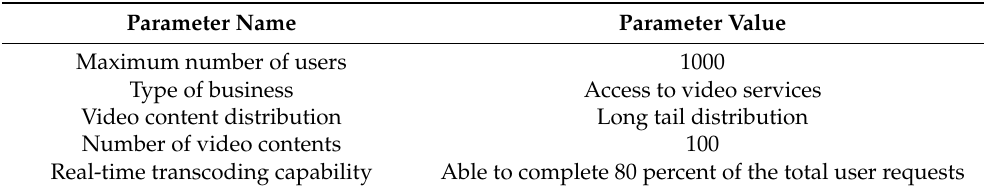
Table 4. Table of the simulated business parameters.